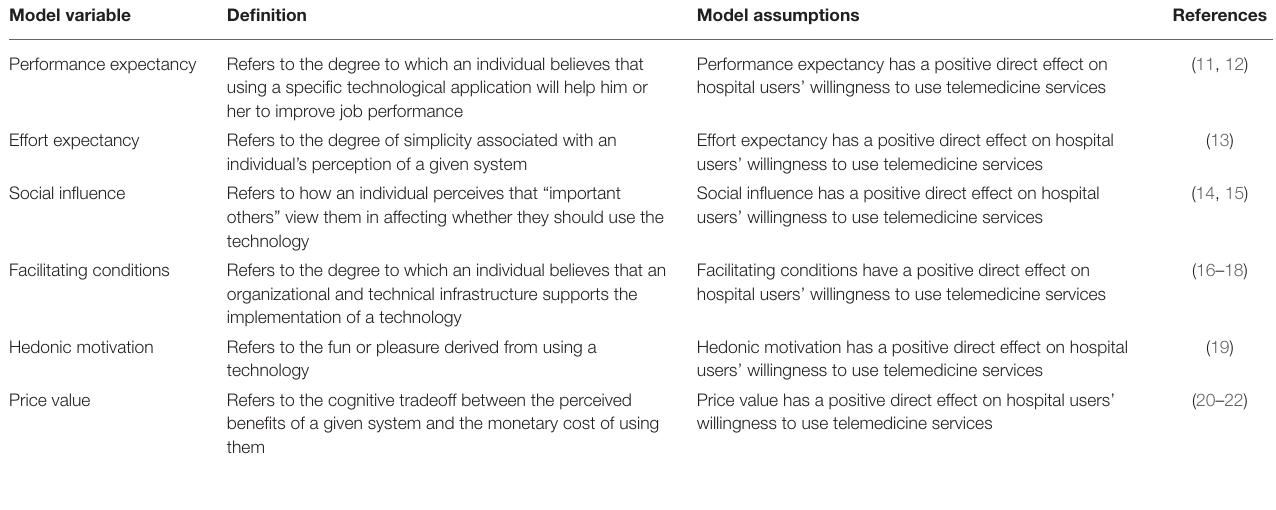
TABLE 1 | Construct definitions and model assumptions.